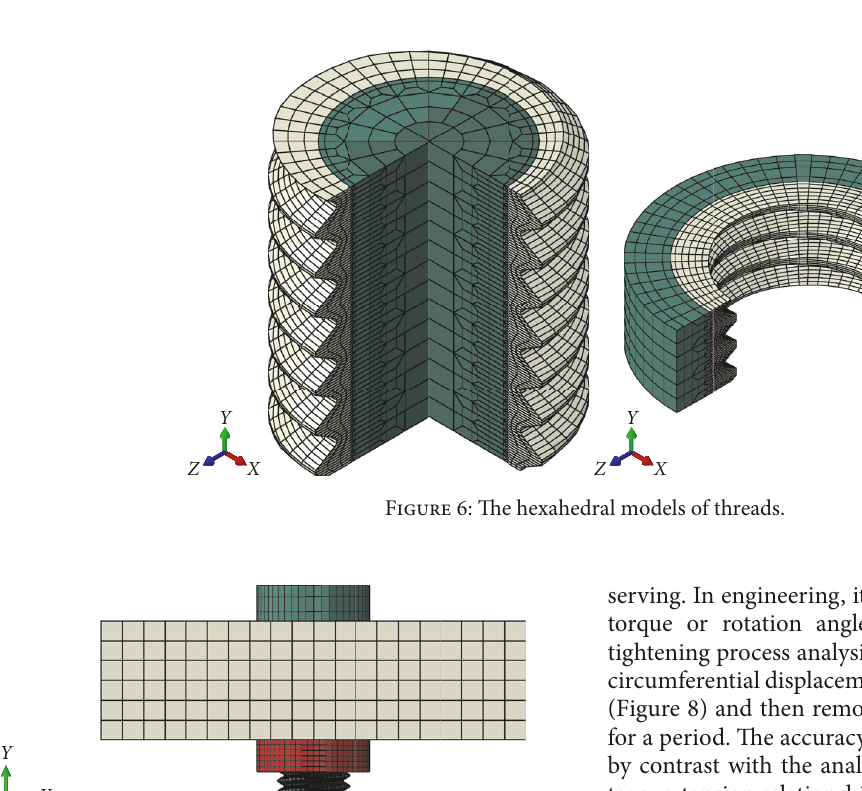
Figure 5: The hexahedral models of cylinders.